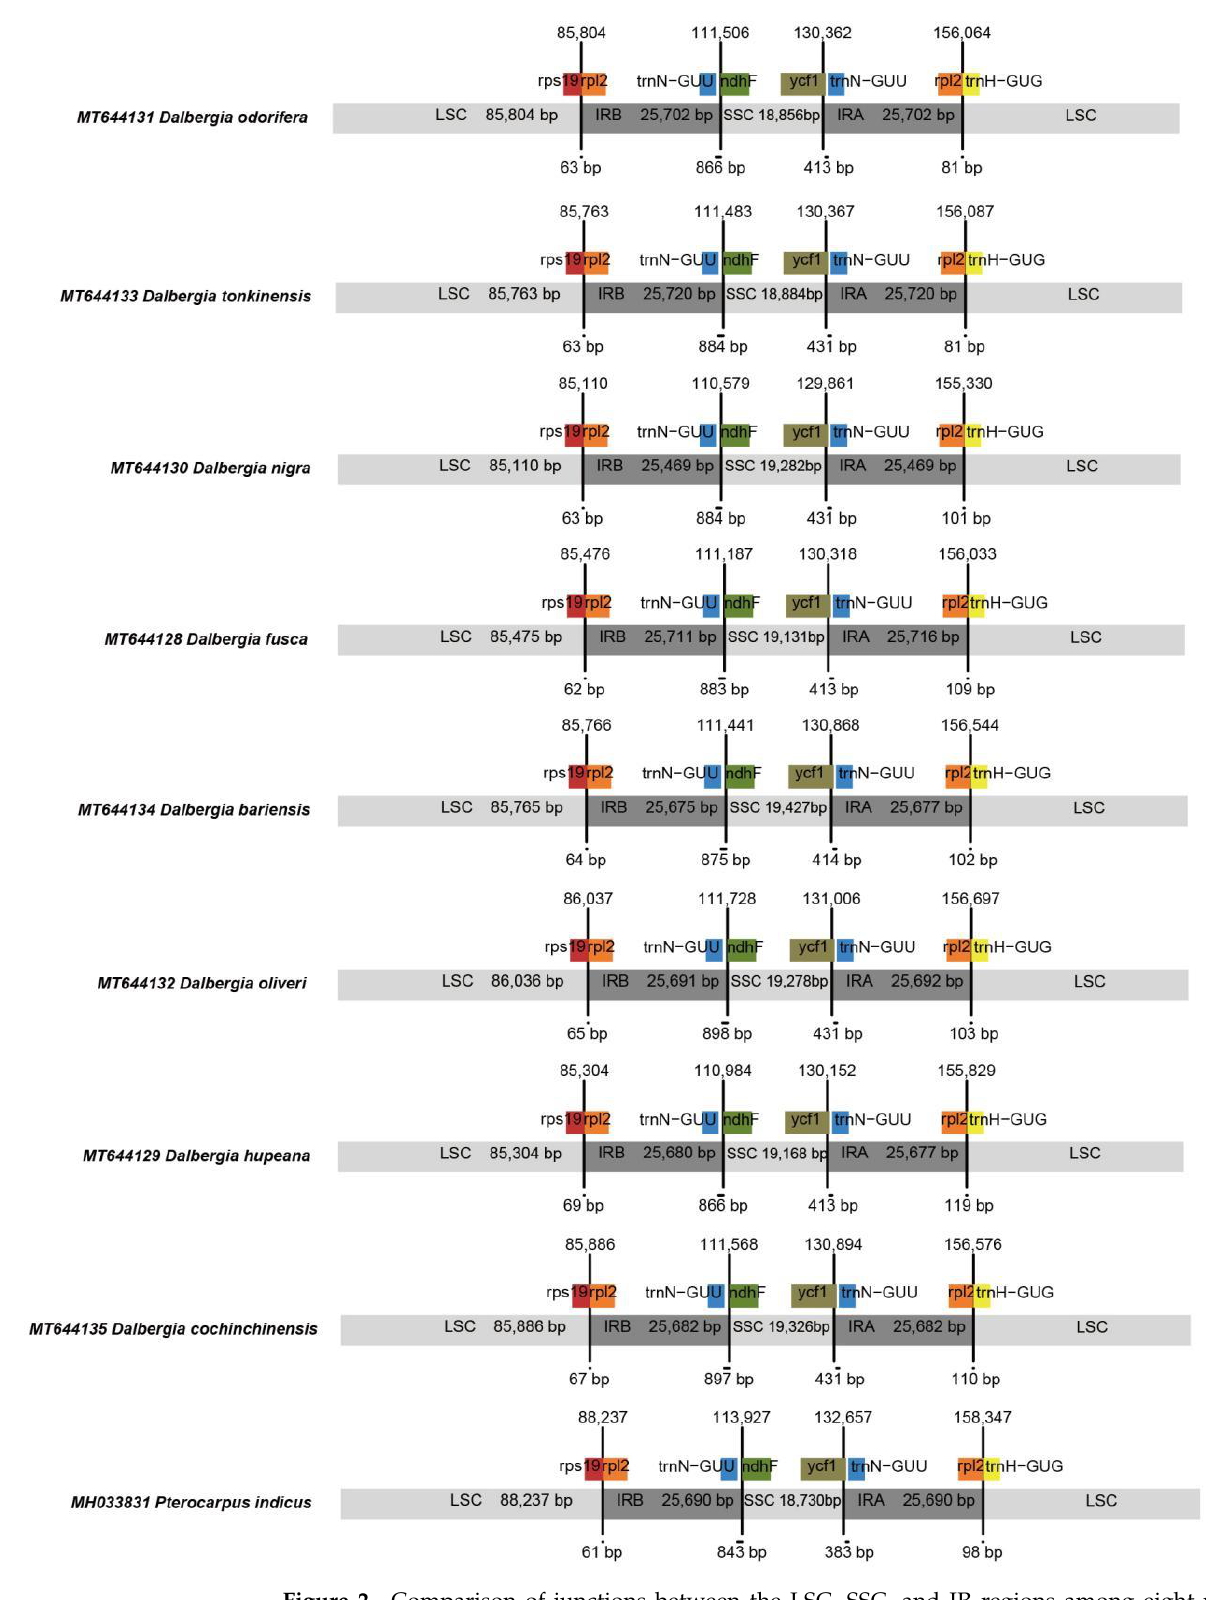
Figure 2. Comparison of junctions between the LSC, SSC, and IR regions among eight newly assembled Dalbergia species and the Pterocarpus indicus chloroplast genome. Figure is not to scale. (LSC: large single-copy, SSC: small single-copy, IR: inverted repeat). The numbers above the vertical line at the junction indicate the positions of the beginning and end of the IR region.